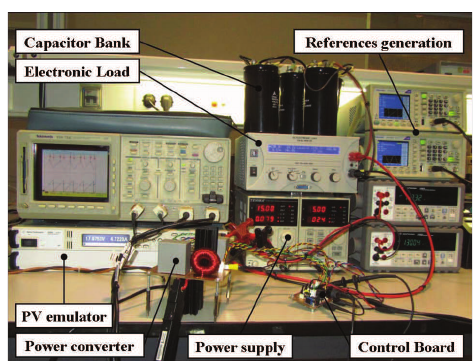
Figure 13. A picture of the experimental setup where the quadratic boost converter, the PV emulator, and the electronic load are used to obtain the experimental